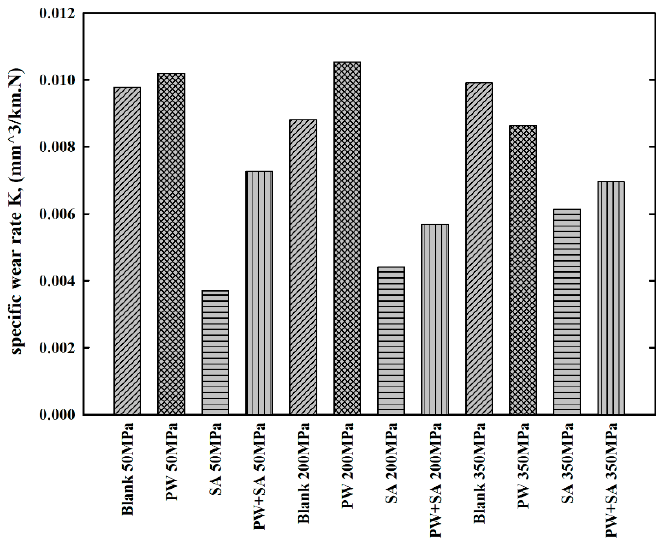
Figure 11. Variations in specific wear rates for sintered Cu–15Fe-based composite samples under different compaction pressure levels.